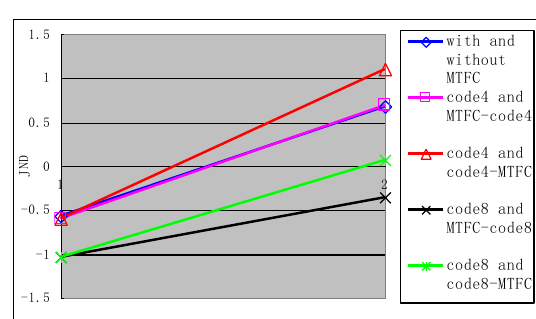
Figure 6. Group A validation of post-processing with compression